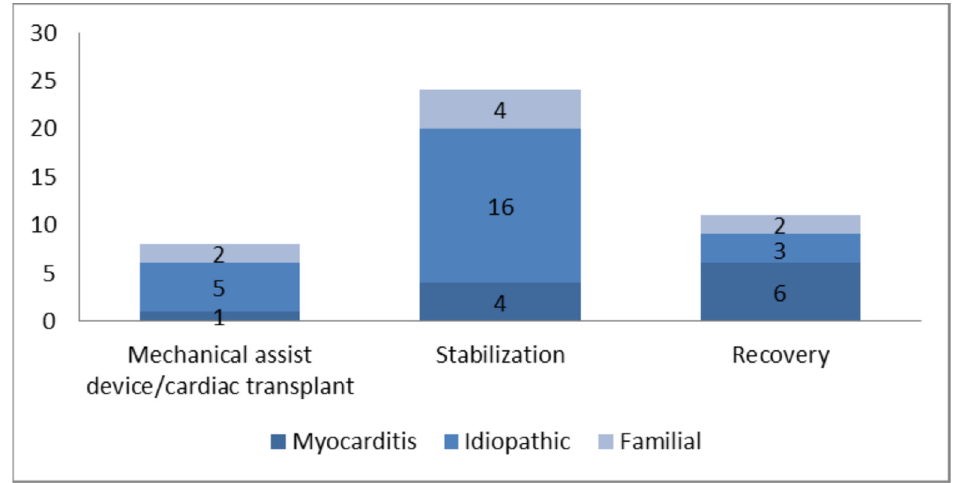
Figure 1. Cause related to outcome.